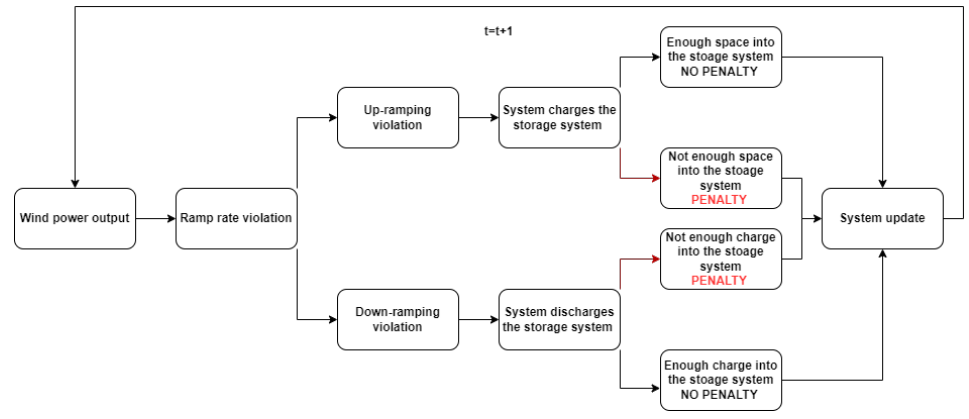
Figure 2. Graphic power smoothing algorithm.